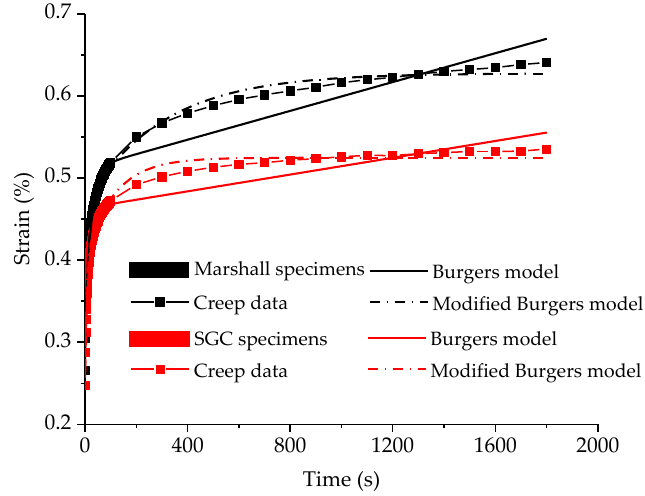
Figure 11. Comparative result of the high-temperature creep test.